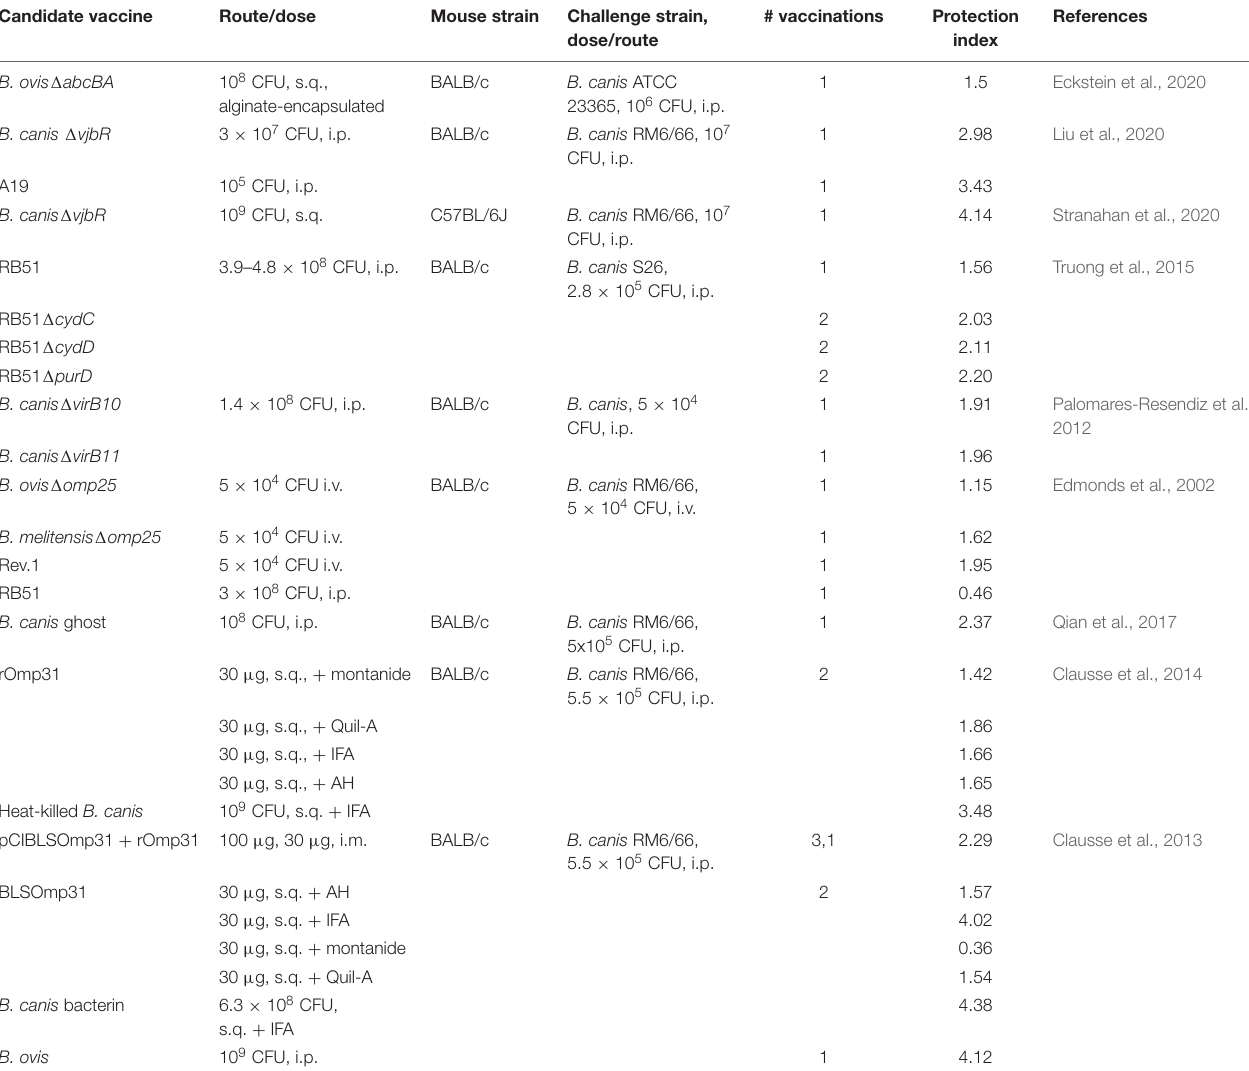
TABLE 3 | Vaccine candidates against B. canis investigated in the mouse model in select studies. Candidate